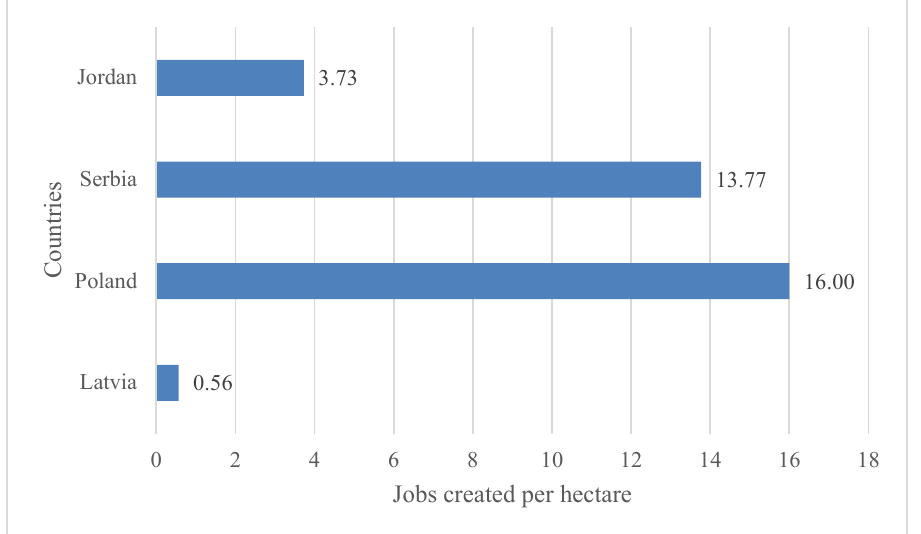
Fig. 3. Jobs created per hectare within the